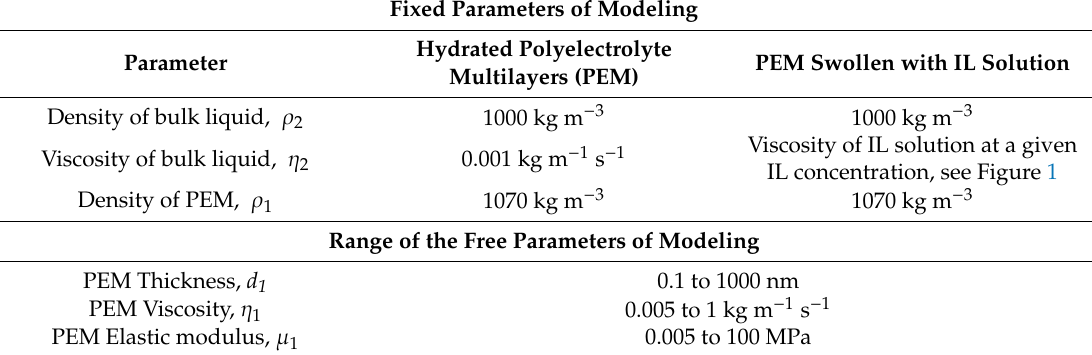
Table 1. Fixed parameters and range of free parameters used for the Kelvin-Voigt modeling of PEI(PSS / PADMAC) 4 PSS and PEI(PSS / PAH) 4 PSS multilayers either in hydrated state or upon exposure to an IL